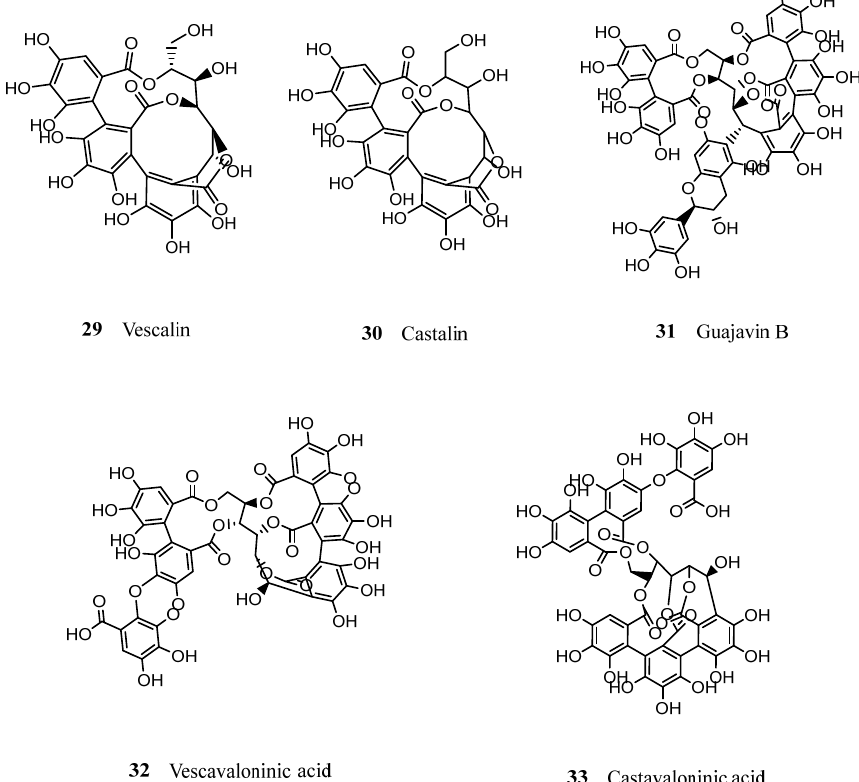
Table 1. Common compounds found in di ff erent cork by-products, based on the yields obtained from extractions described in literature.